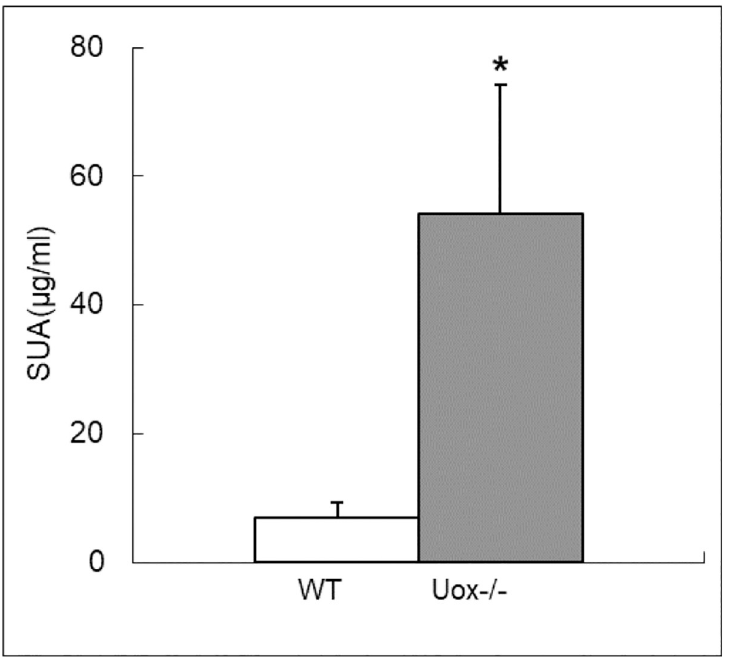
Fig 3. Serum Uric Acid (SUA) in the Wild-Type (WT) and Uox -/- male rats (Uox -/- ) weighing 180–220 g [mean ± SD, n = 10 (WT) or = 11(Uox -/- )]. � P < 0.05, vs WT, one-way ANOVA.